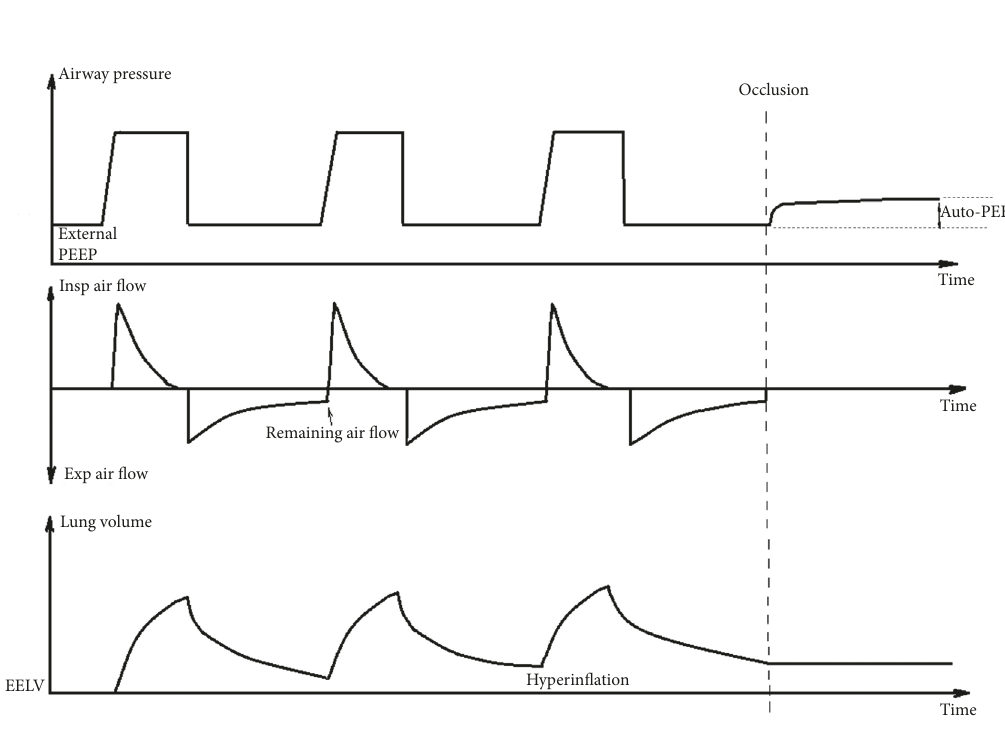
Figure 2: Ventilatory curves for three consecutive breaths during pressure controlled ventilation in a patient with dynamic hyperinflation and auto-PEEP, measurement of static auto-PEEP after